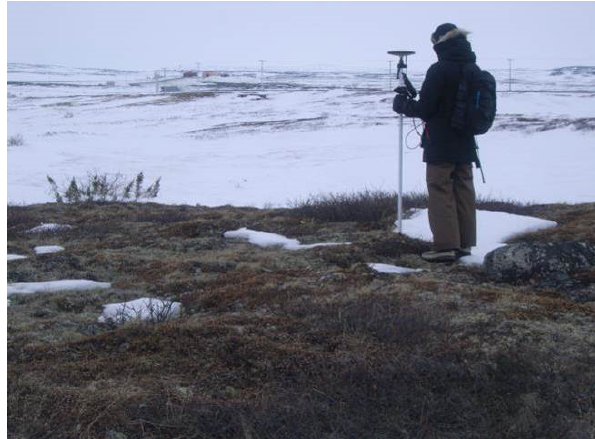
Figure 6. Photo taken in April 2010 showing sparse snow cover on the lithalsas (Lithalsa M in this case) during the field visits.